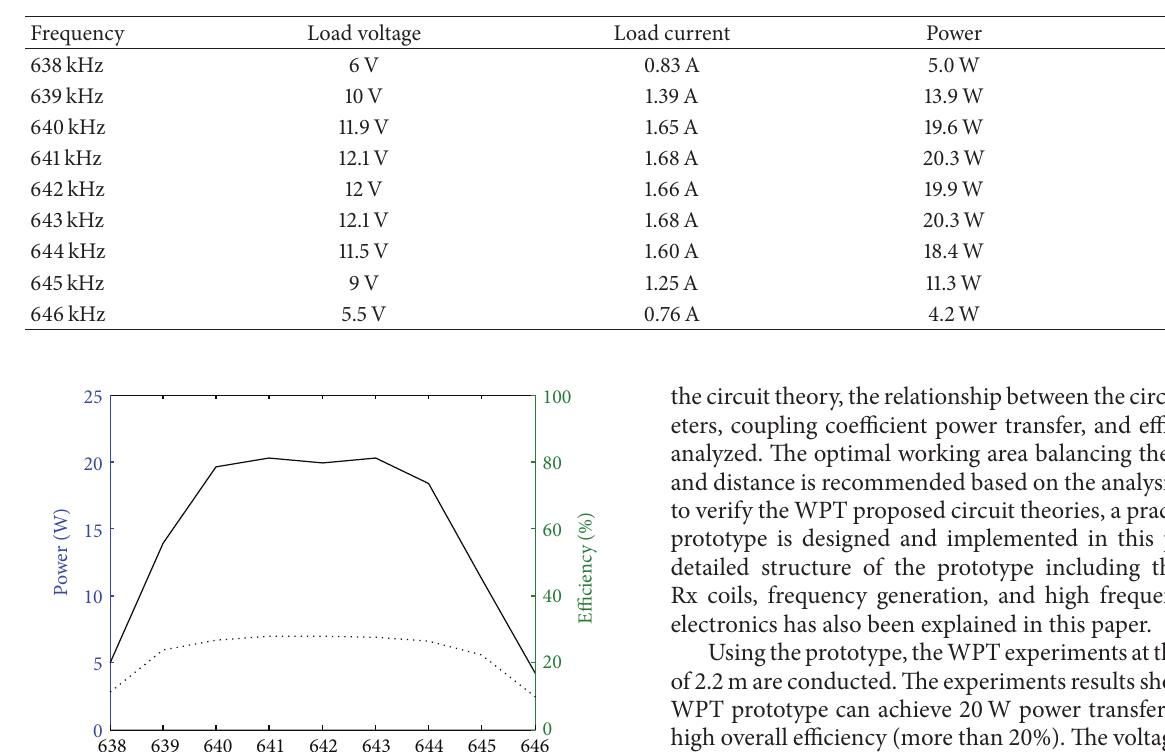
Table 2: Circuit parameters.